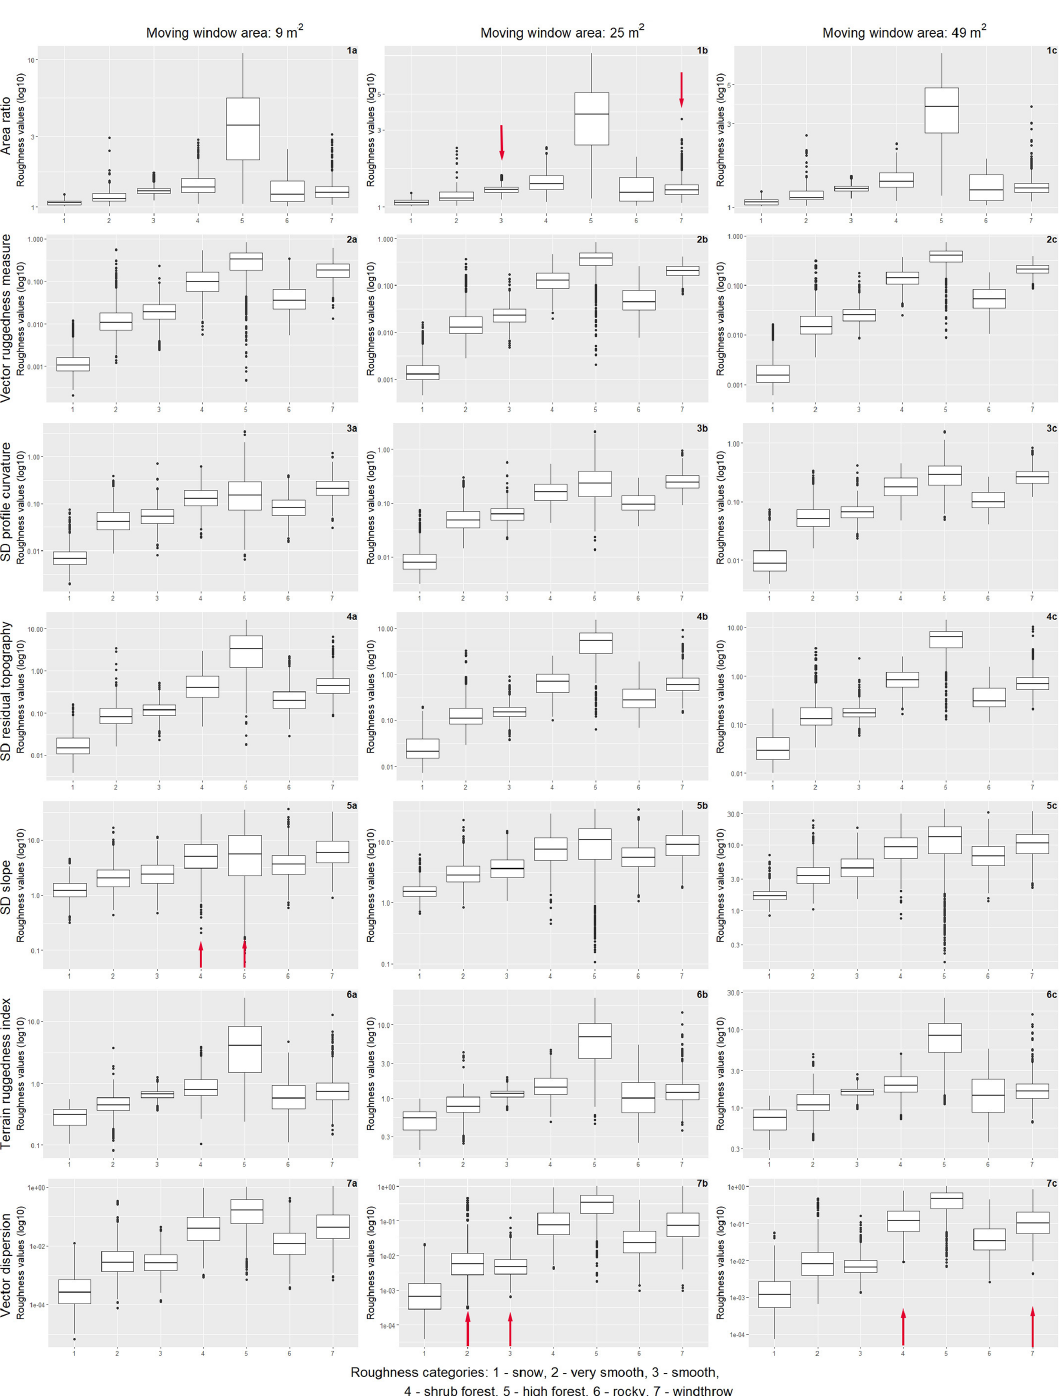
Figure 4. Distribution of roughness values according to different roughness categories (1 – snow, 2 – very smooth, 3 – smooth, 4 – shrub forest, 5 – high forest, 6 – rocky, 7 – windthrow) for seven algorithms (area ratio, vector ruggedness measure, SD of profile curvature, SD of residual topography, SD of slope, terrain ruggedness index and vector dispersion) for the spatial resolution of 1m. Red arrows show the overlapping distribution for a pair of categories that the given algorithm fails to